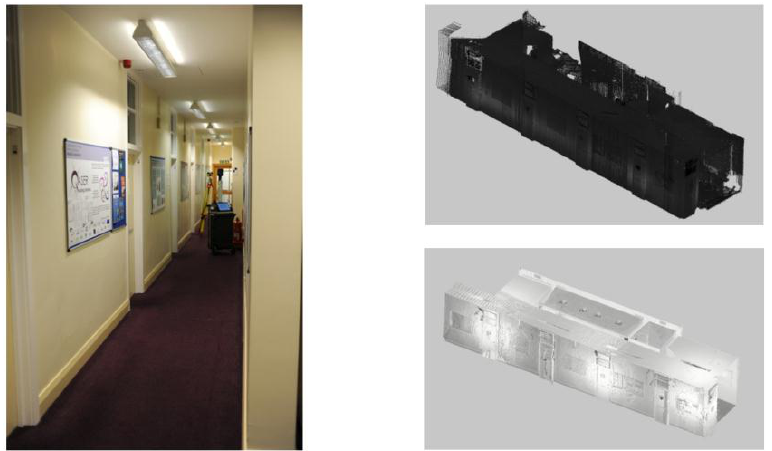
Figure 5. Image of corridor ( left ) and resulting point cloud data collected with a Viametris Indoor Mobile Mapping System ( top right ) and Faro Focus 3D S ( bottom right